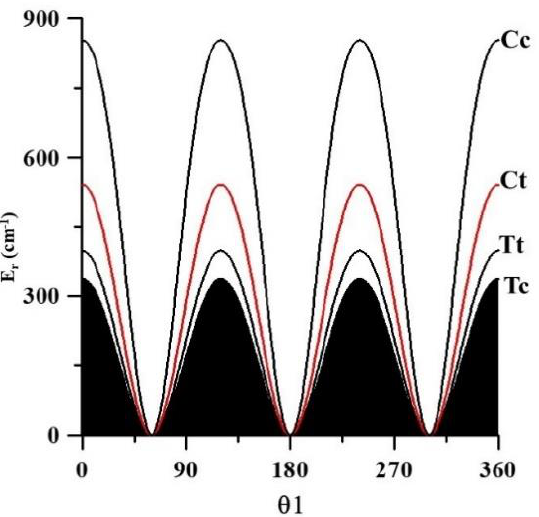
Figure 3. CH 3 torsional barrier.